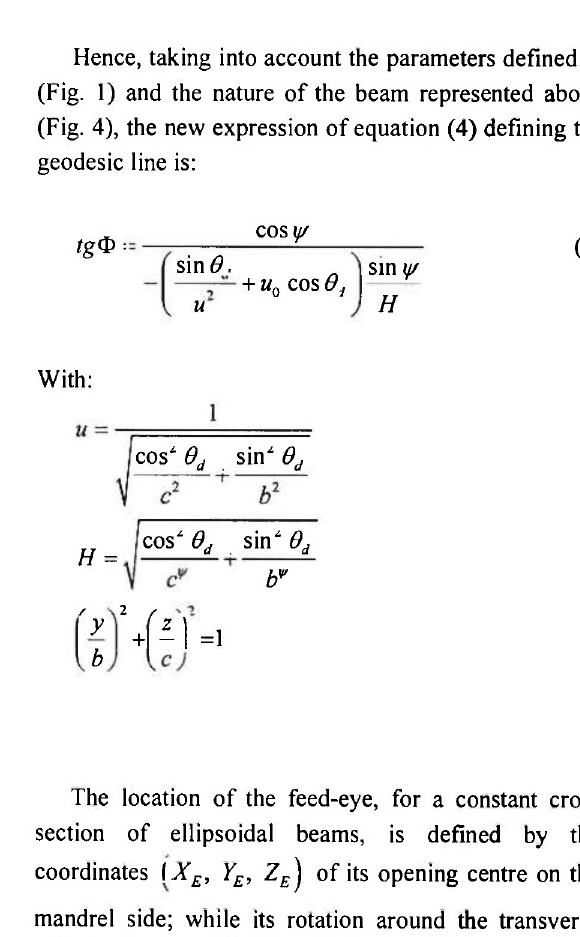
Fig. 3-a: The longitudinal view of the beam